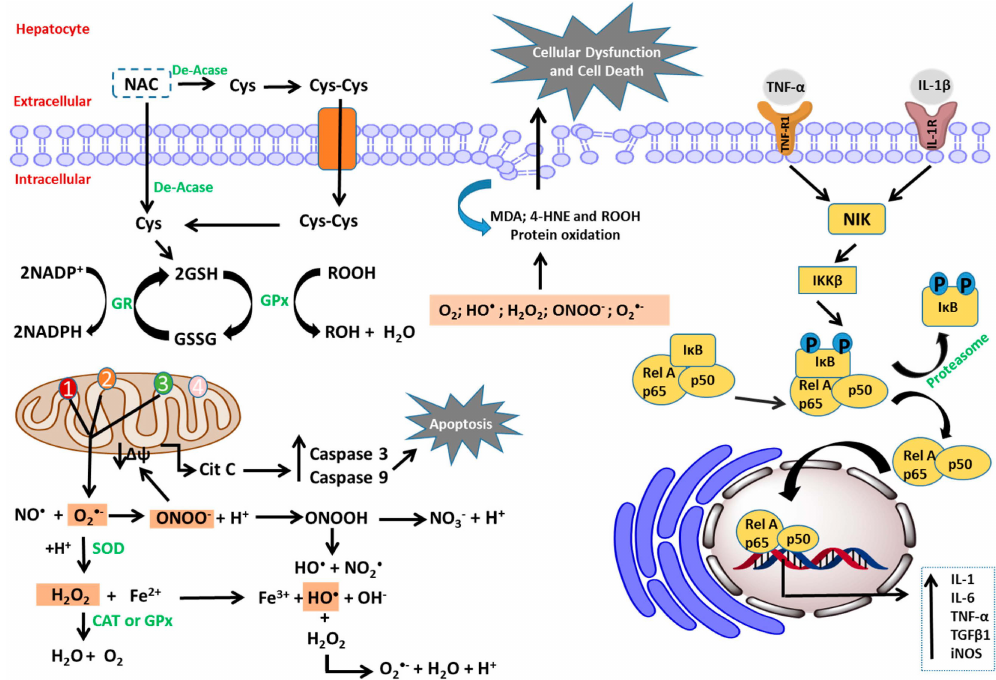
Figure 3. Transport of N -acetyl- L -cysteine and pathways for the generation of oxidative stress and inflammation in hepatocyte. Legend: CAT: catalase; Cys: cysteine; Cys-Cys: cystine; Cit c: cytochrome c; De-Acase: deacetylases; GSH: reduced glutathione; GSSG: oxidized glutathione; GPx: glutathione peroxidase; GR: glutathione reductase; HNE: 4-hydroxynonenal; iNOS: inducible nitric oxide synthase; IKK β : inhibitor of κ B kinase; I κ B: inhibitor of NF- κ B; IL: interleukin; IL-1R: interleukin-1 receptor; MDA: malondialdehyde; NADP + : oxidized nicotinamide adenine dinucleotide phosphate; NADPH: reduced nicotinamide adenine dinucleotide phosphate; NIK: NF- κ B-inducing kinase; NO ¨ : nitric oxide; NAC: N -acetylcysteine; NF- κ B: nuclear factor κ -light-chain enhancer of activated B cells; p65: